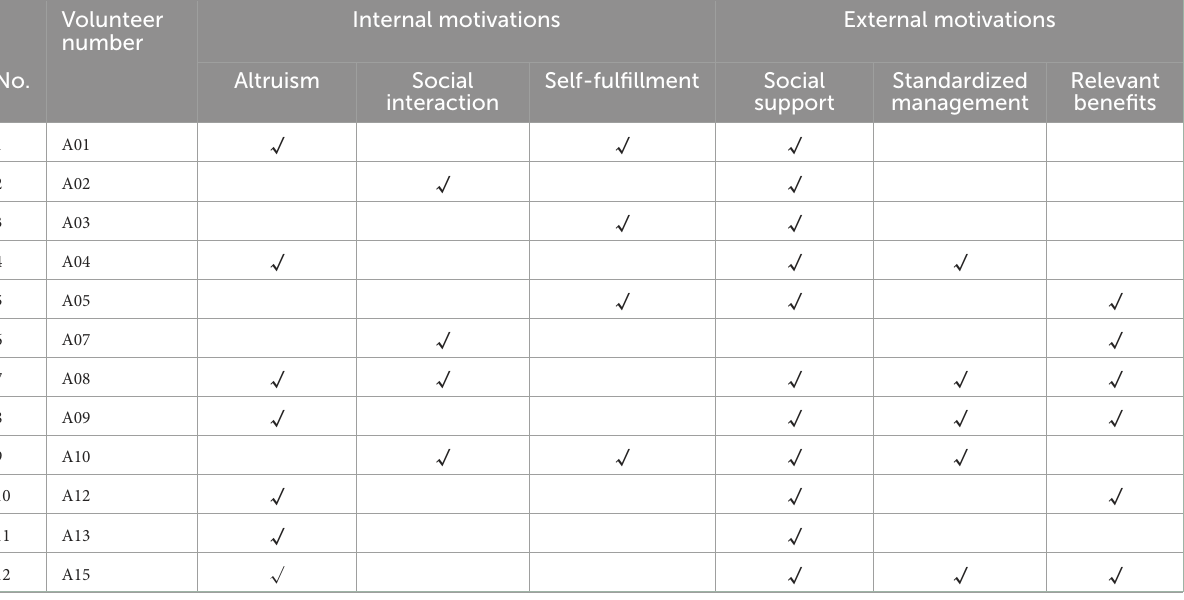
TABLE 3 Selective coding